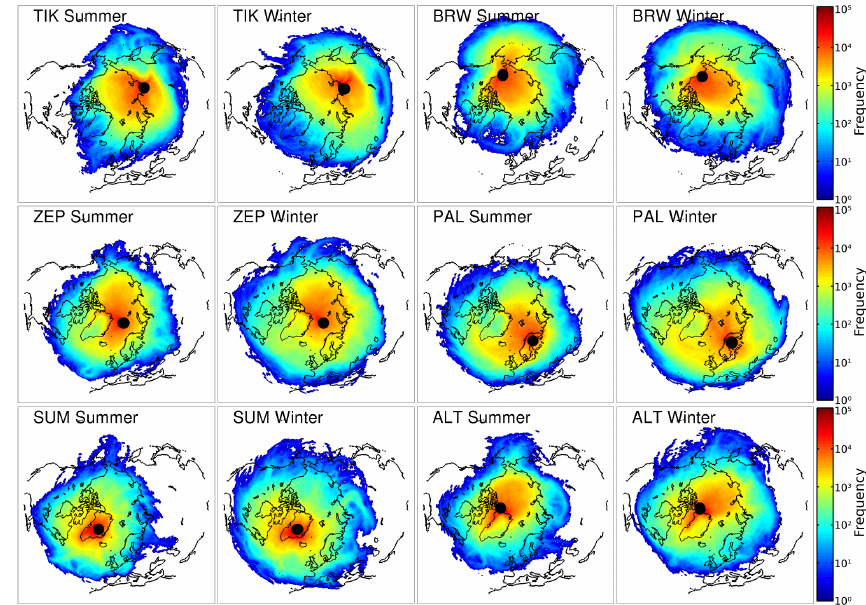
Figure 9. Seven-day back trajectories at each of the six Arctic stations, separated by summer (May–October) and winter (November–April) months. Colors represent frequency (units of hours per 2 years) at which an air parcel travels over that region before arriving at the station, in other words, residence time of air in that location. These plots show data from all trajectory altitudes. Black dots show station